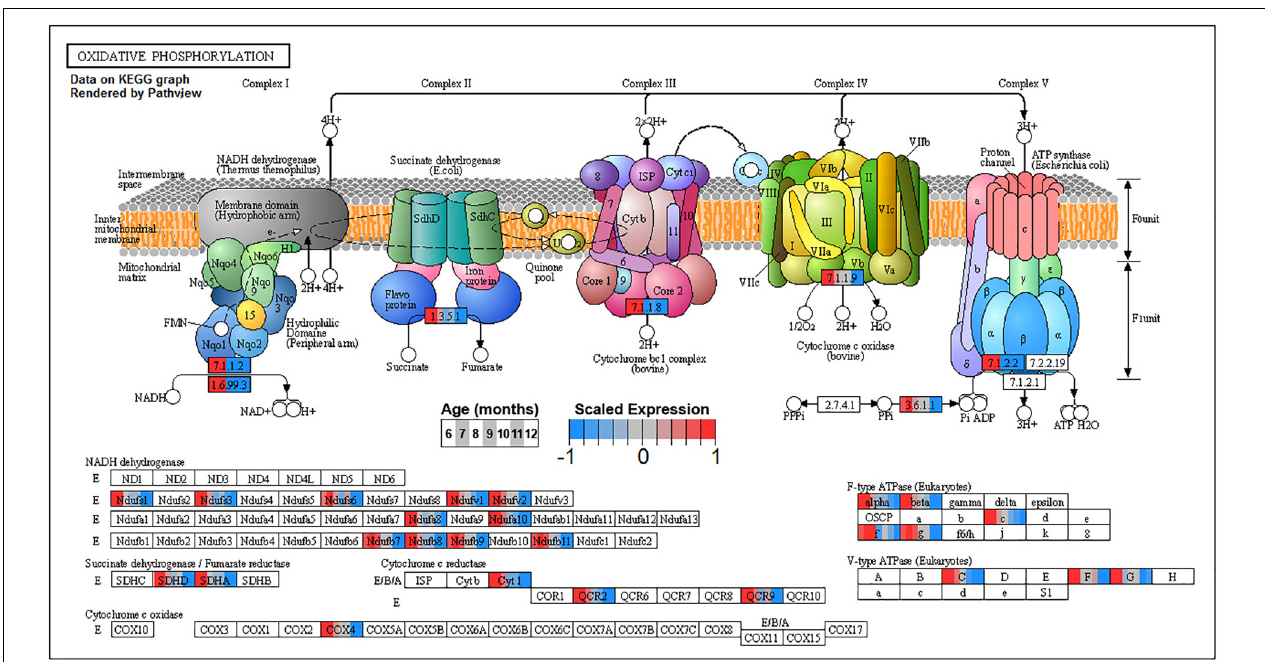
FIGURE 10 | Expression of orthologs annotated for the Kyoto Encyclopedia of Genes and Genomes (KEGG) oxidative phosphorylation (ko00190) pathway present in pleural ventral caudal sensory neuron (PVC) expression clusters with decreasing trend (P4 and P5). Each node of the pathway diagram represents an ortholog assigned to an Aplysia californica transcript. Nodes are divided into seven colored sections, from left to right, ages 6 to 12 months. Node sections are colored according to their mean centered and variance scaled expression, together representing the expression trends of each node across the aging process. Nodes that are not colored were absent from the gene sets of expression clusters P4 and P5. Pathway enrichment indicates that all components of the electron transport chain in mitochondria are inhibited with aging and thus energy production from ATP synthase is likely to be reduced with aging.